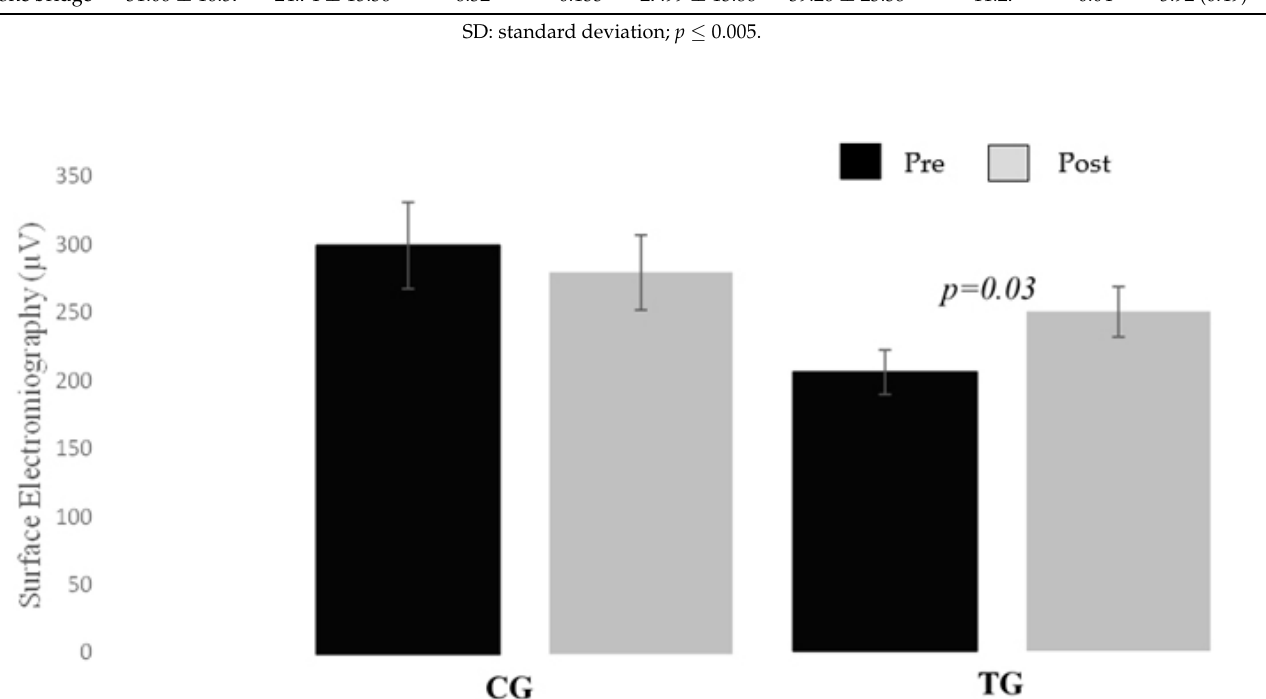
Figure 3. Significant difference EMG rms front in prone bridge endurance test/TG.